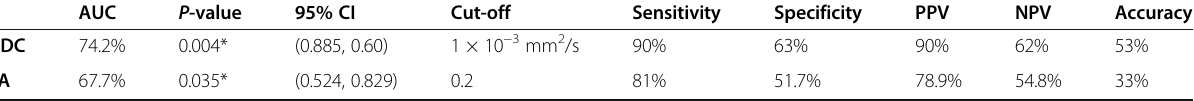
Table 6 Diagnostic performance (sensitivity, specificity) of ADC and FA to predict breast malignant tumor (vs. benign)